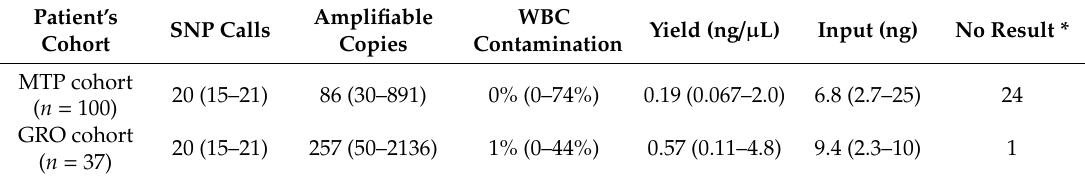
Table 2. Liquid IQ ® results for the Montpellier (MTP) and Groningen (GRO) cohorts.